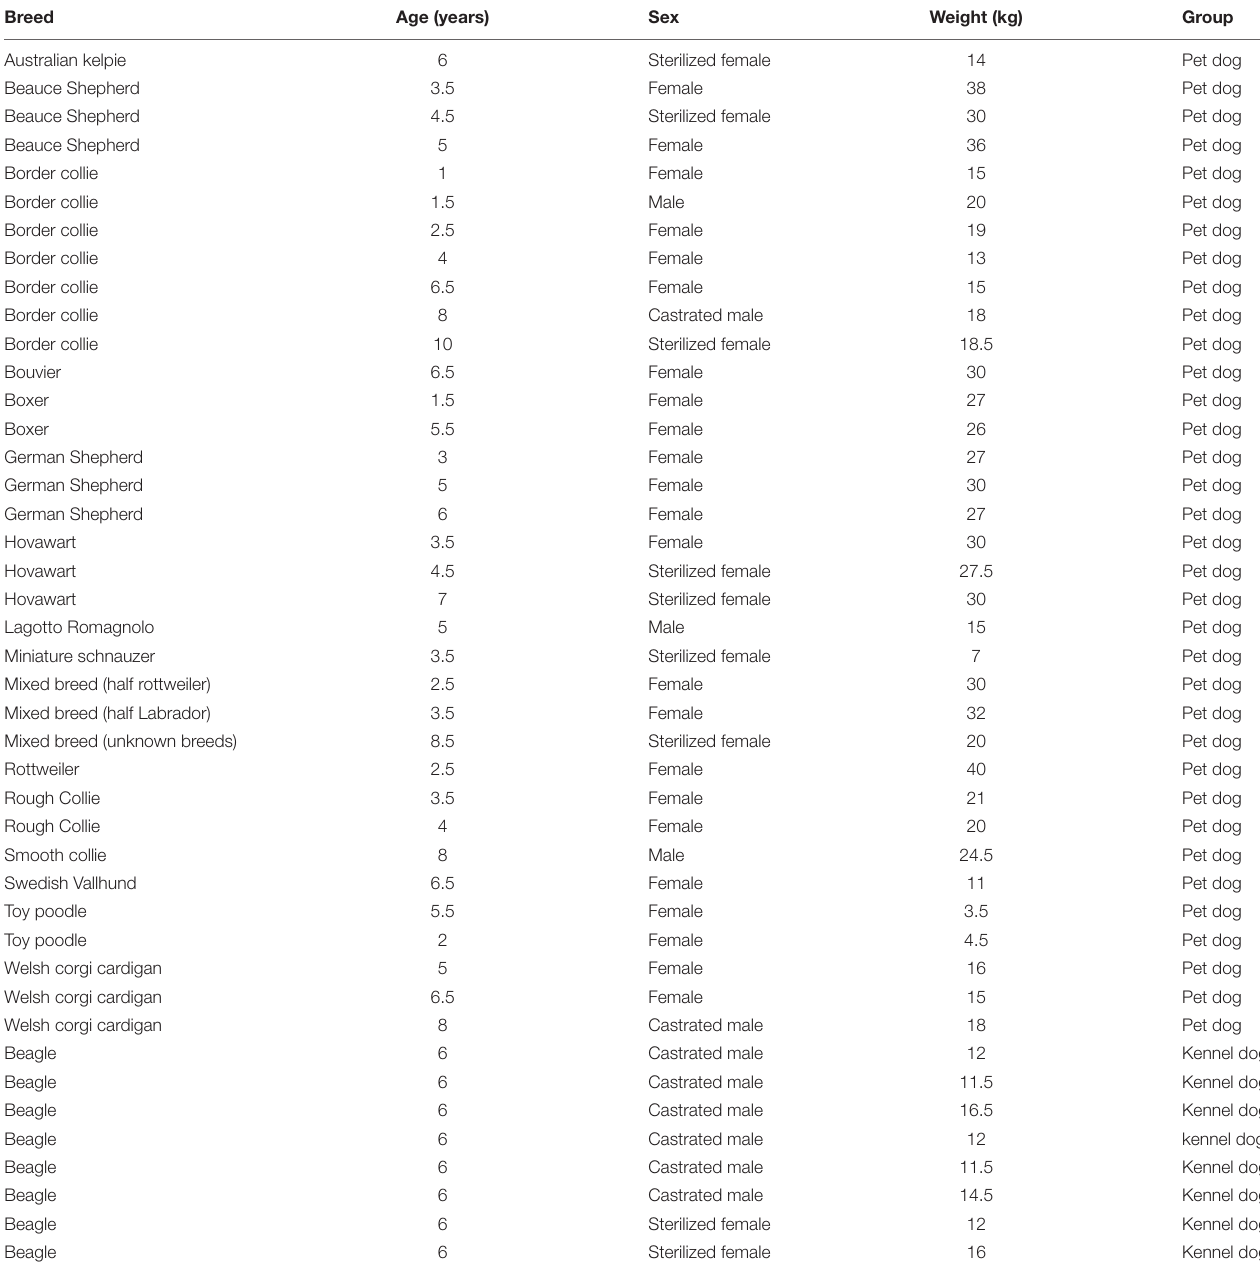
TABLE 1 | Breeds, ages, sex and weights of the